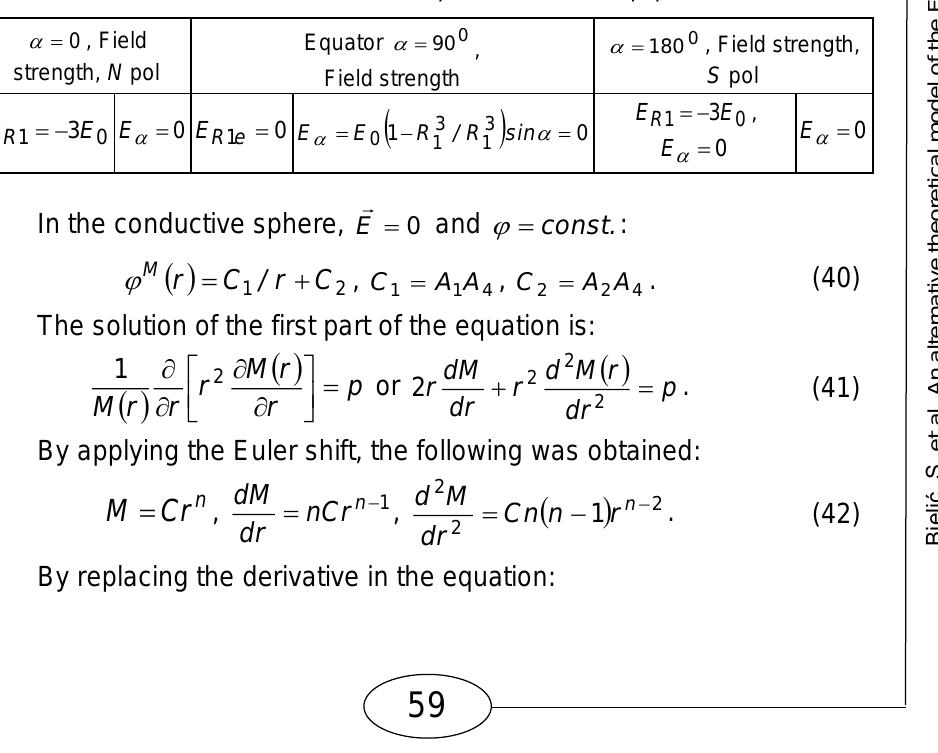
Table 1 – Field strength in the